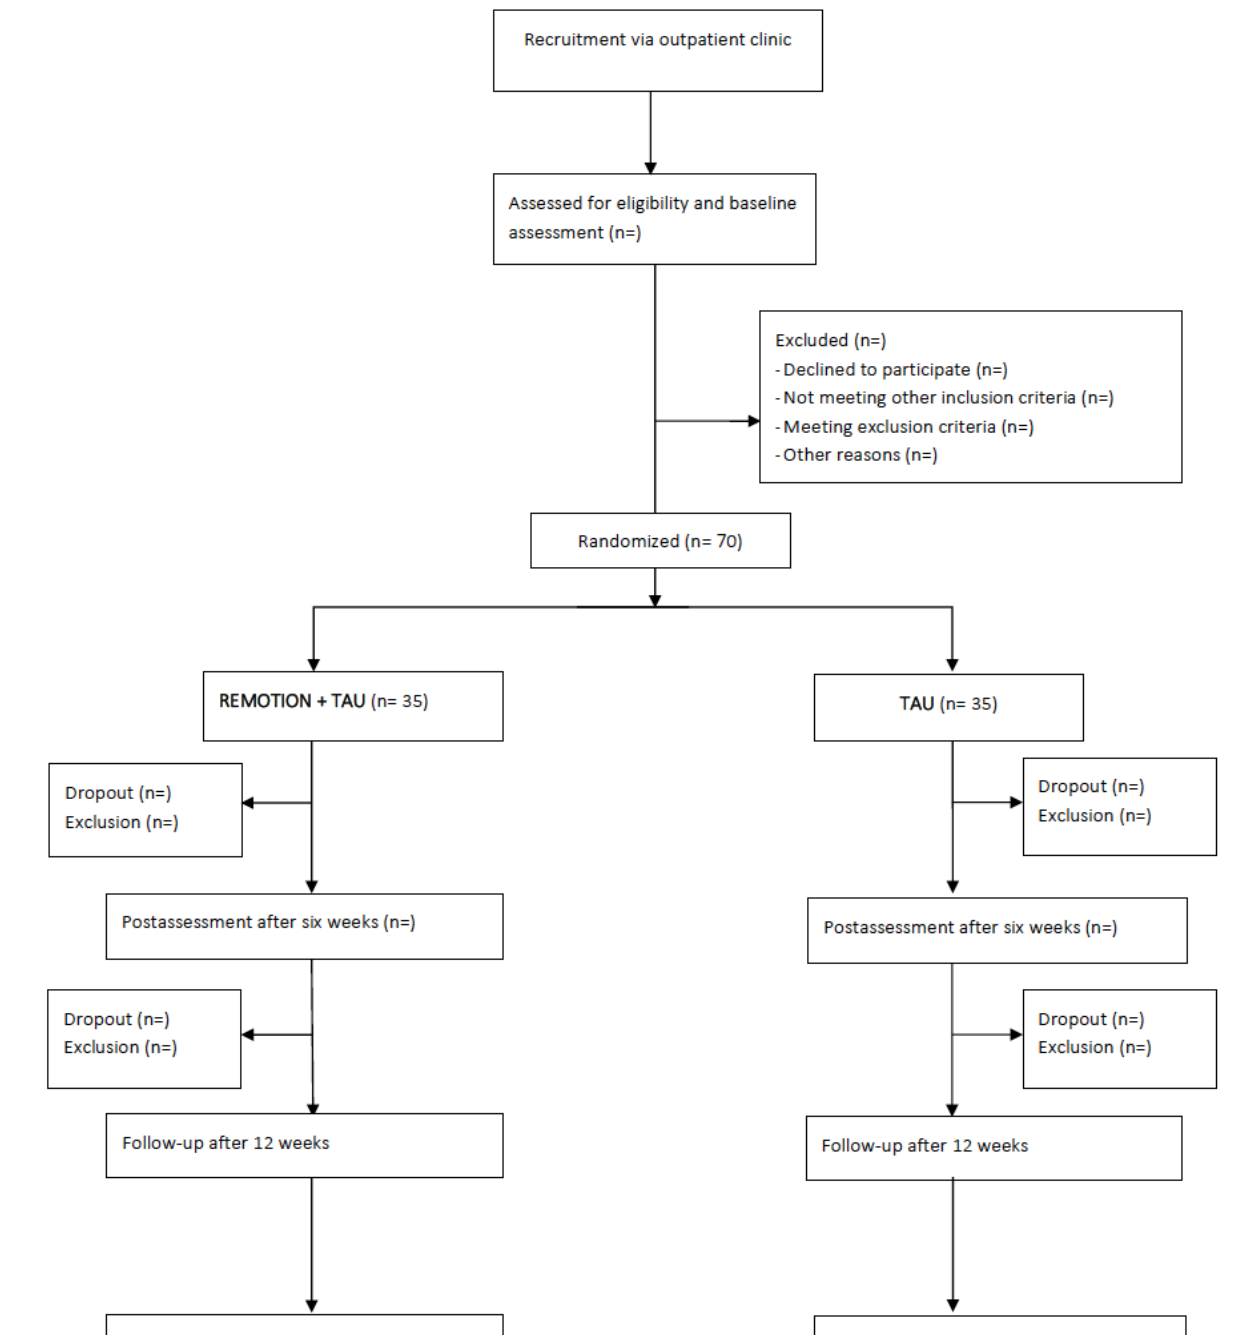
Figure 1. Participant flow. TAU: treatment as